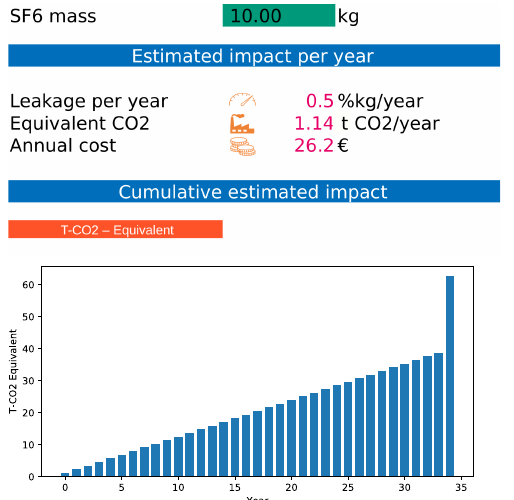
Figure 5. Estimation of SF 6 leakage for a new project according to the parameters given in Table 2.